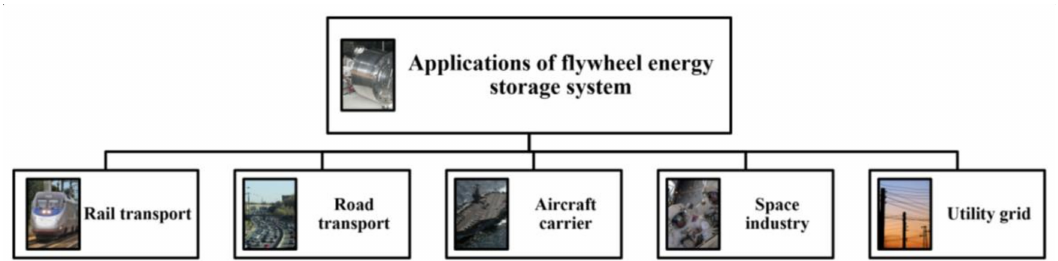
Figure 16. Applications of flywheel energy storage system.